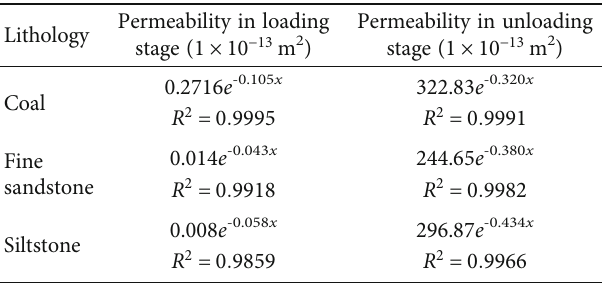
Figure 3: Curves of permeability and axial pressure. (a) Loading stage. (b) Unloading stage. Table 1: Fitting function of coal/rock sample permeability and axial